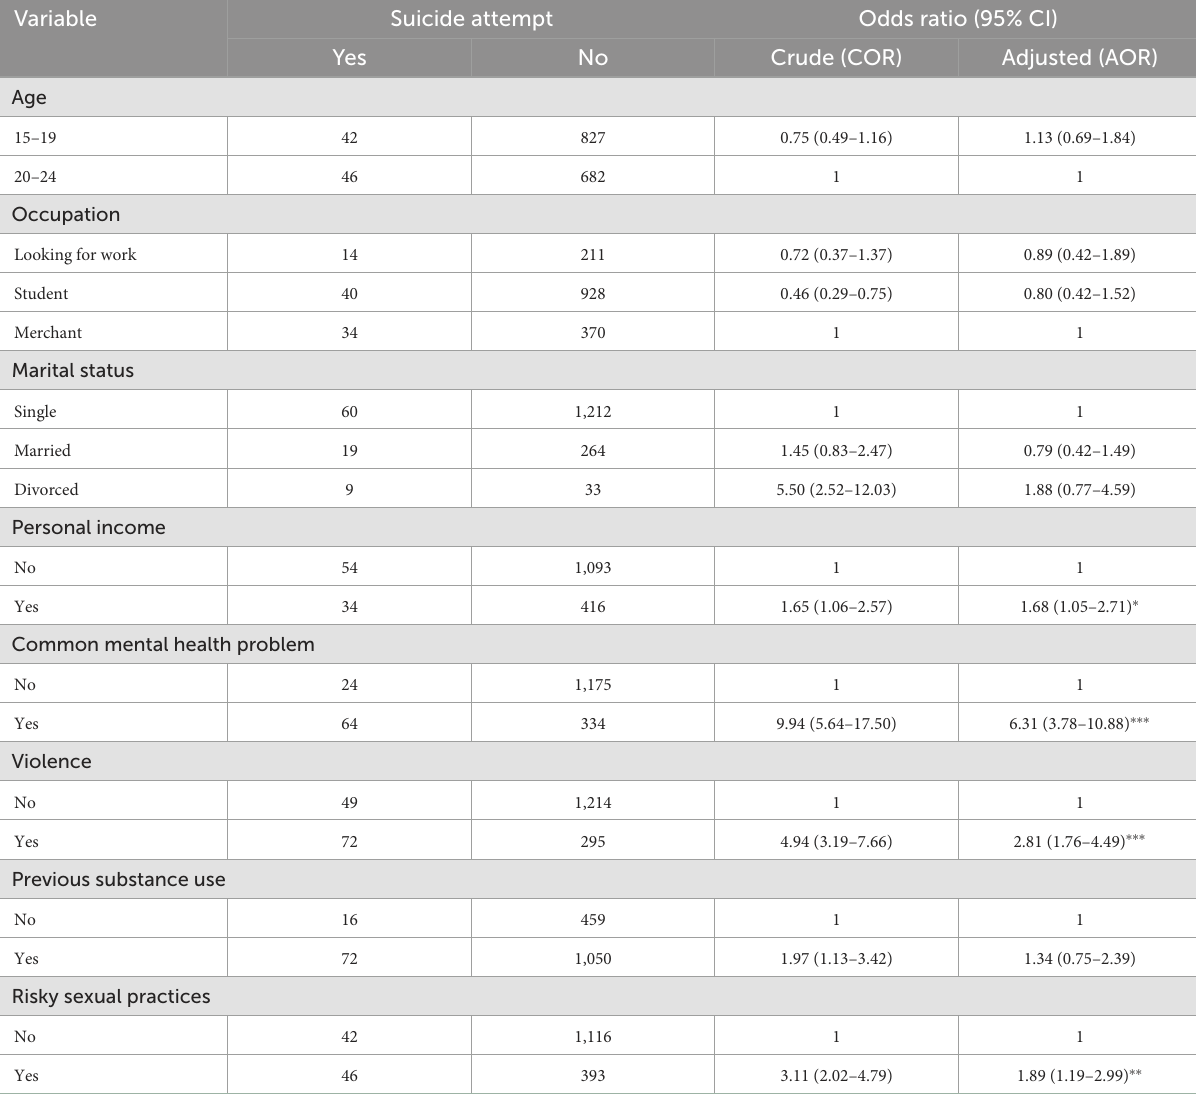
TABLE 5 Logistic regression analysis of factors associated with suicide attempts among youths living in the central, west, and north Gondar zones.